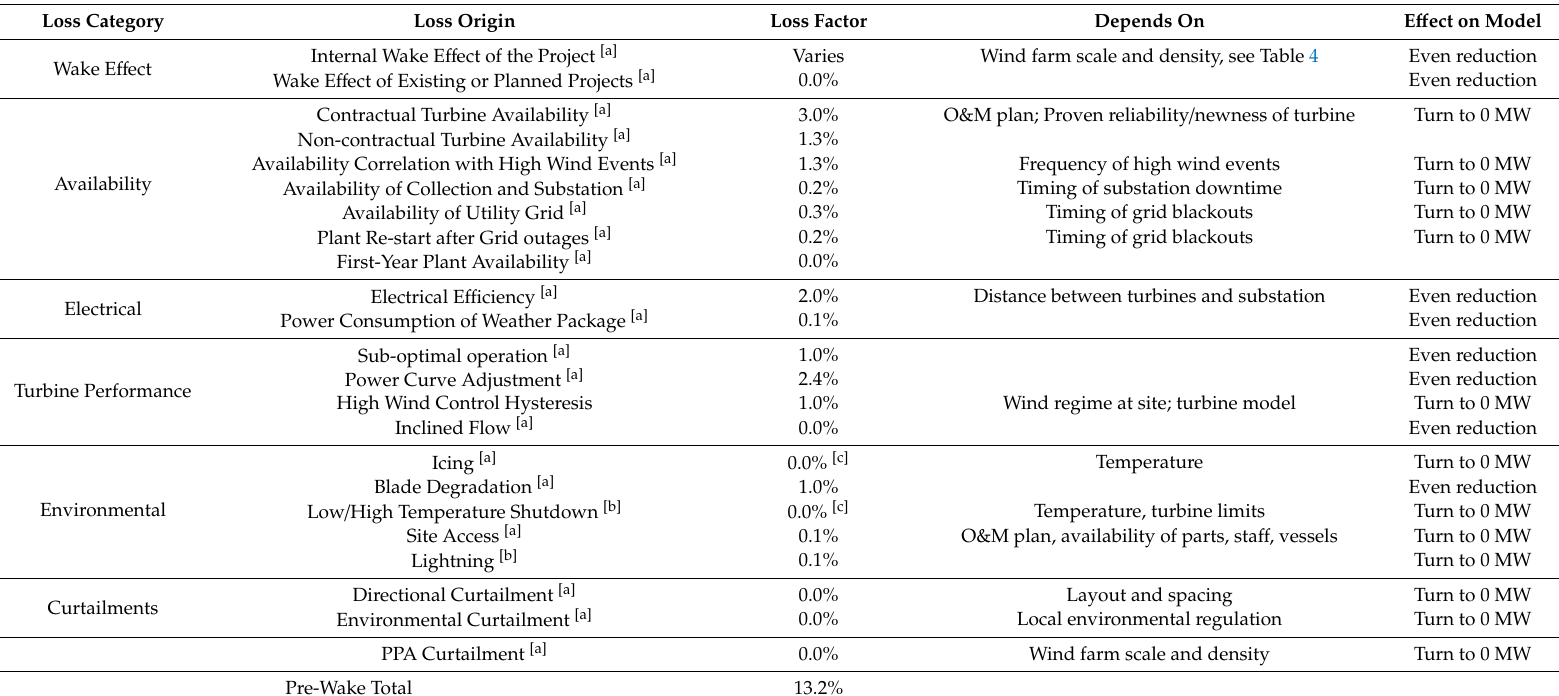
Table A1. Geographic specifications of study